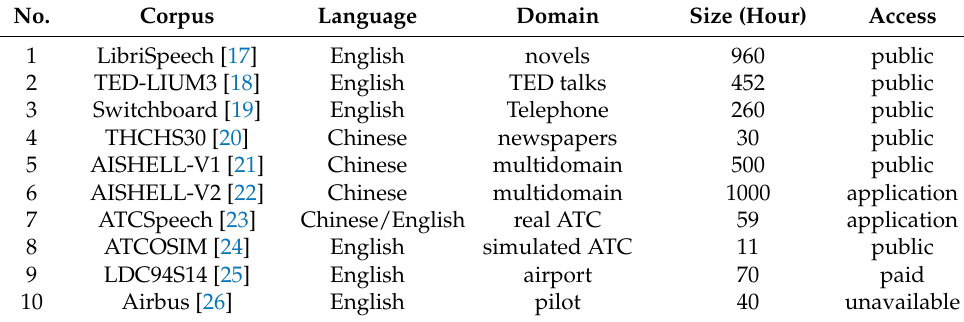
Table 1. A summary of the speech corpora